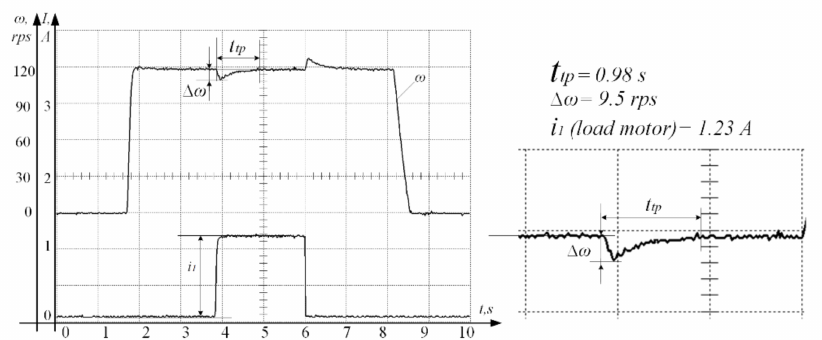
Figure 6. Asynchronous drive process charts with speed vector control and PID-regulator.